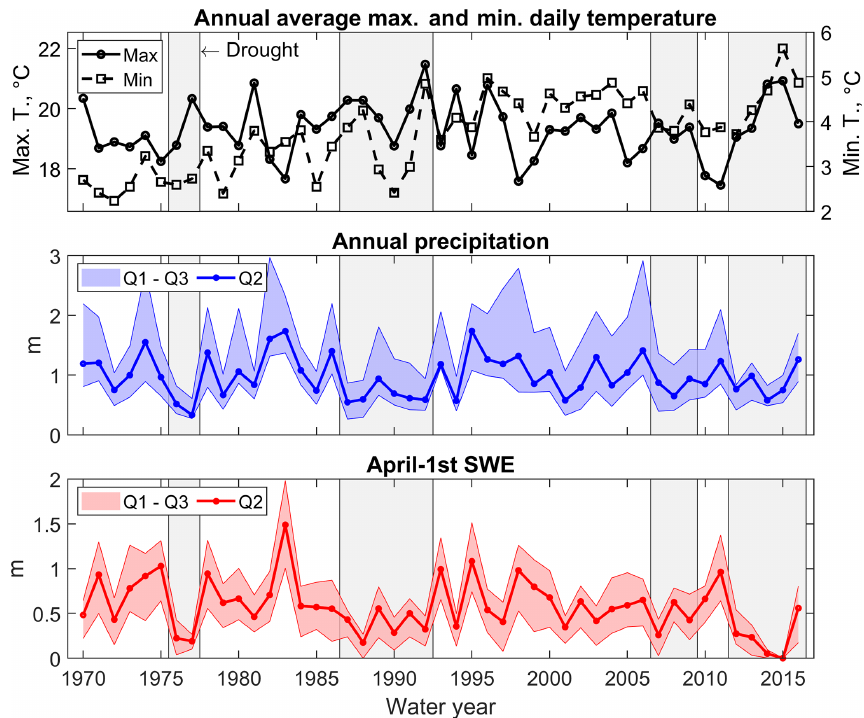
Figure 2. Hydroclimatic summary of the four most recent Californian droughts compared to non-drought years. Maximum and minimum daily temperature is an annual average of the three index stations used by the PRMS model for air-temperature inputs: Canyon Dam (1390m), Quincy (1066m), and Bucks Creek Powerhouse (536m). Annual precipitation and 1 April SWE were computed using 13 and 25 stations across the Feather River, respectively (see Tables S2 and S3). Q 2 is the spatial median and Q 1 and Q 3 are the two quartiles, respectively.